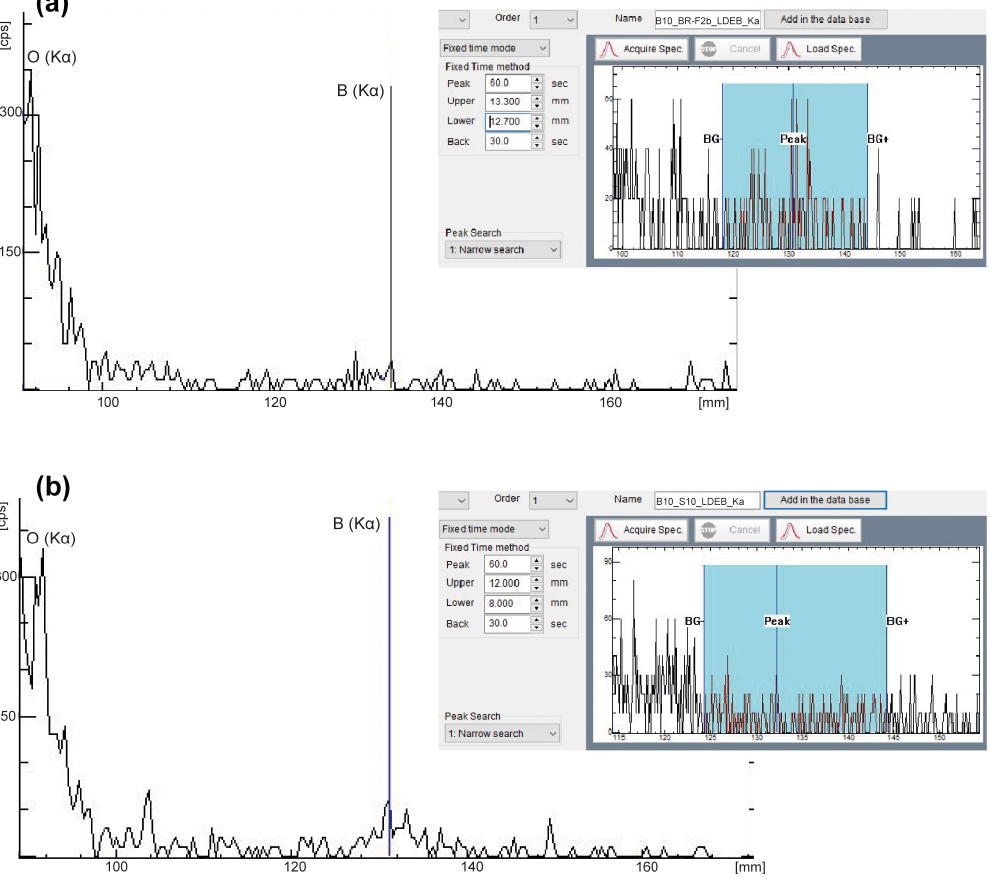
Figure 1. Peak position of boron using an LDEB diffraction crystal and determination of the background ( ± BG). Panel (a) refers to the standard glass BR-F2 and (b) to the Harvard-Schorl S10. With the wide qualitative scan, one can best examine the width of the peaks under consideration and neighboring peaks, while in the narrow scan (here the inserts) the background can best be determined (limits of the blue area). Table 1. Major constitutes and boron of used standards (denoted by a ) and test materials. b signifies an informative value. Element